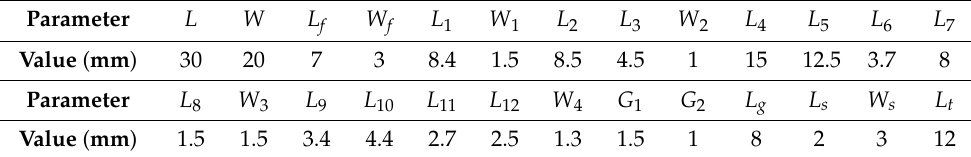
Table 1. Dimensions of the quad-band antenna.